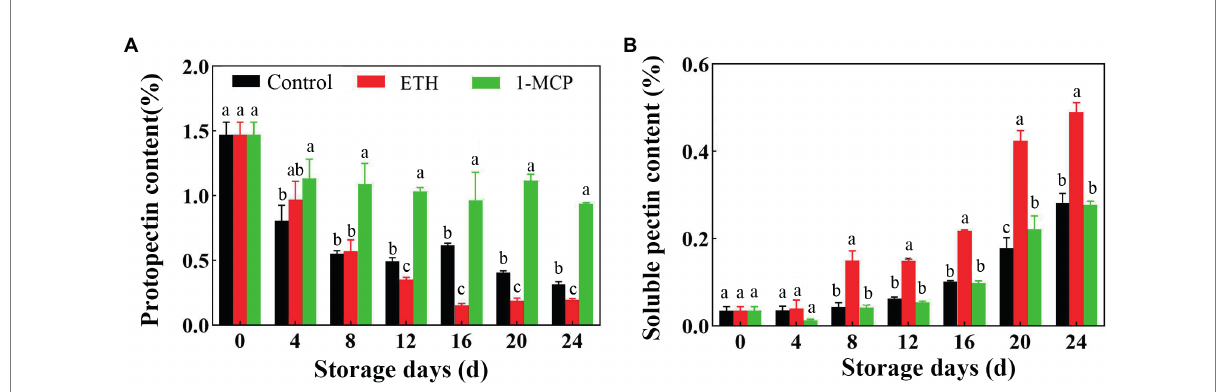
FIGURE 2 Effects of different treatments on contents of protopectin (A) and soluble pectin (B) in mango fruit during storage at 15 ° C. The data are presented as means ± standard deviations. Means with different letters are significantly different at p <